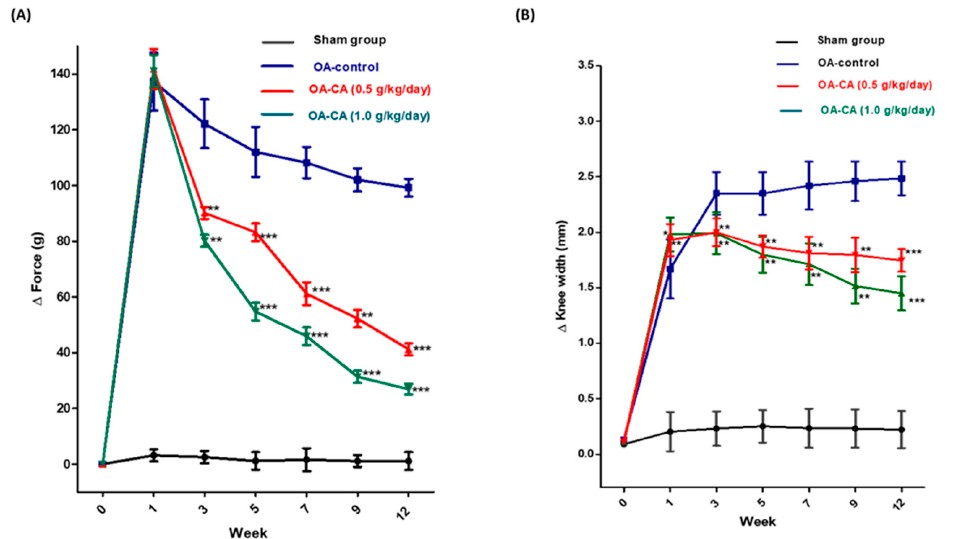
Figure 3. The effects of CA on ( A ) weight bearing and ( B ) knee width in ACLT + MMx induced OA knee. Measured the weight bearing and knee width of the sham, OA-control, OA-CA (0.5 g/kg/day), and OA-CA (1.0 g/kg/day) groups for 12 weeks. Data from all experiments are expressed as the mean ± S.D. * p < 0.05, ** p < 0.01, and *** p < 0.001.